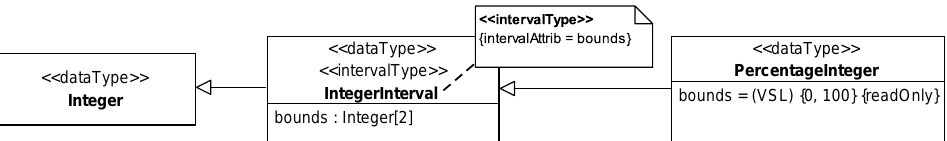
Figure 10. Example data type definition using utility types of the MARTE model library (UML 2.5